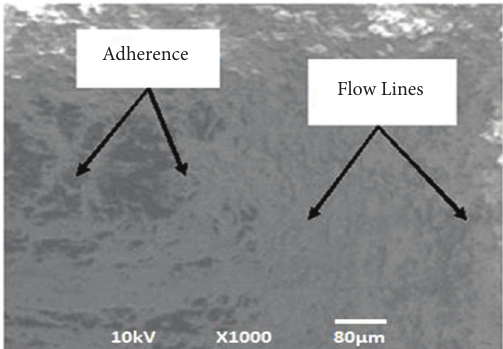
Figure 10: SEM micrograph of neat polypropylene (PP) sample at